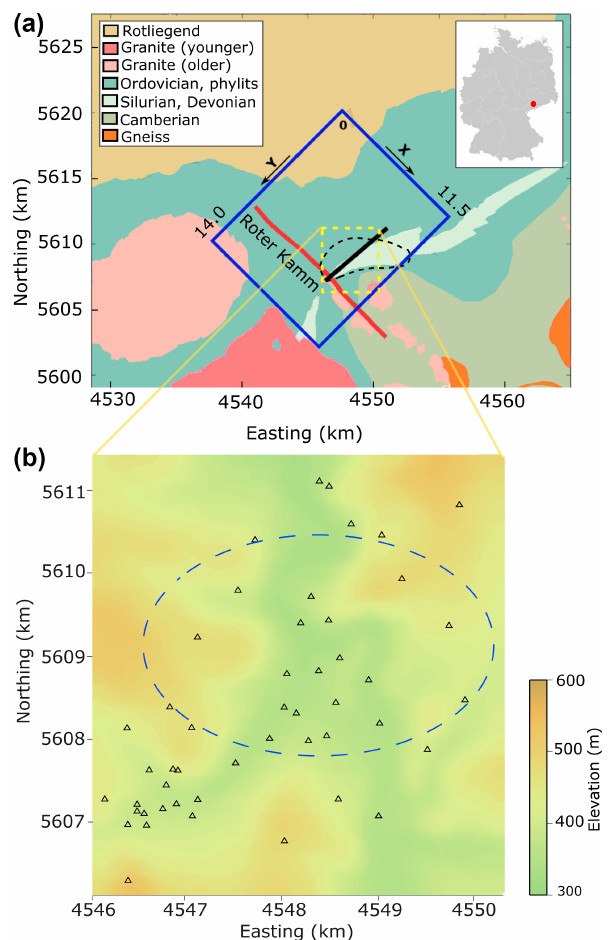
Figure 1. Geological map of the study area (a) . The blue square shows the position of the 3D model in this study and the 3D active seismic image cube; the dashed yellow square refers to the extent of the local seismic network, and the solid black line shows the po- sition of the vertical profile in Fig. 2; the approximate border of the mining area is marked by the dashed black line. The local seismic network used in this study (b) . The stations are shown by triangles, and the dashed blue ellipse marks the area where the hypocentres used in this study are located.